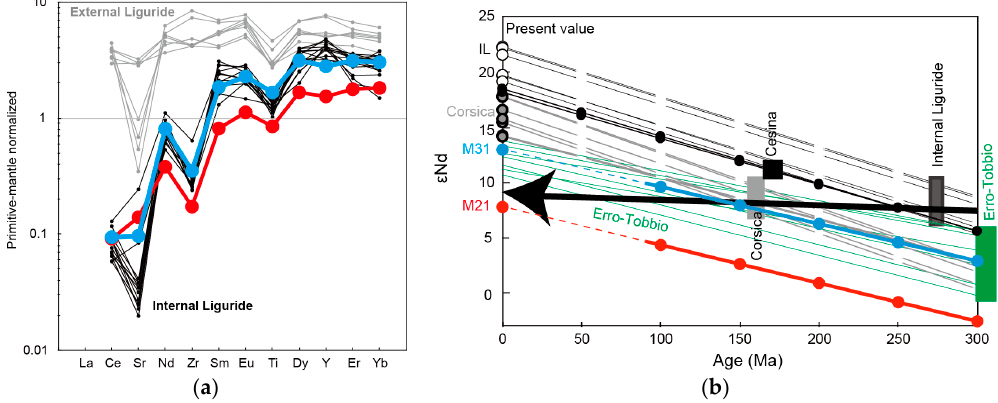
Figure 12. ( a ) Primitive-mantle-normalized trace element patterns of averaged clinopyroxene from the Middle Andaman and those of clinopyroxenes in spinel lherzolites from the Internal Liguride and External Liguride peridotites [39,40]. ( b ) Relationships between ε Nd of clinopyroxene and time for the studied Middle Andaman Ophiolite and the western Tethyan ophiolites. The ε Nd values at 275 Ma for Internal Liguride [40], at 160 Ma for Corsica [41], and at 175 Ma for Cesina [42] are interpreted as initial ε Nd values. The ε Nd value of the Erro-Tobbio at 300 Ma is the value at the time of emplacement of the massif [43]. Depleted mantle evolution model (large arrow) is from